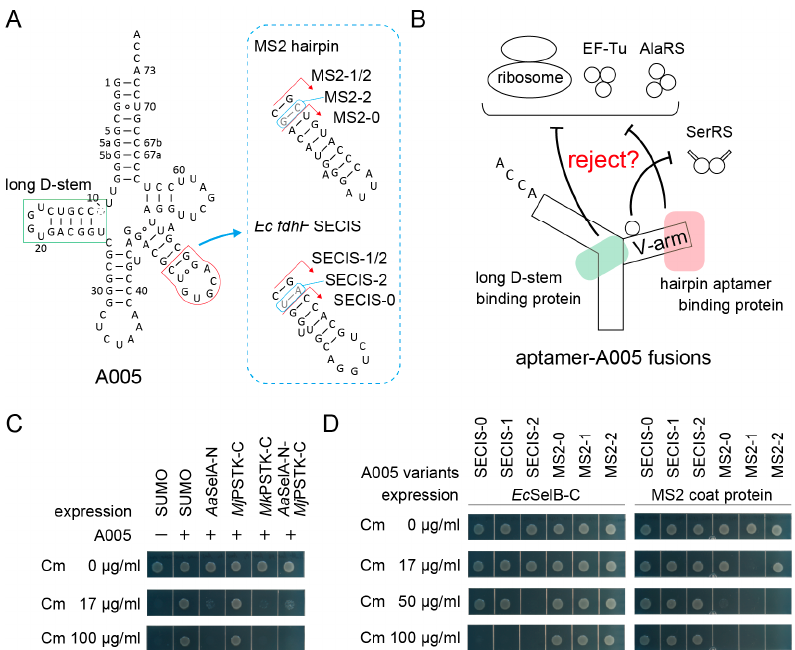
Figure 3. Sequestration of aptamer-tRNA fusions from the E. coli translation system via the expression of the cognate aptamer-binding proteins. ( A ) The cloverleaf structure of A005 tRNA variants having a hairpin RNA aptamer in the V-arm. The long D-stem of (9/3) allo-tRNAs and tRNA Sec species is a binding site for tRNA Sec -binding enzymes SelA and PSTK. ( B ) Strategy for the sequestration of the aptamer-A005 fusion variants. ( C ) The A005 tRNA molecules were almost fully sequestered by the N -terminal domain of Aquifex aeolicus ( Aa ) SelA and the C -terminal domain of Methanopyrus kandleri ( Mk ) PSTK but not by the C -terminal domain of Methanocaldococcus jannaschii ( Mj ) PSTK. ( D ) The SECIS-A005 fusions were sequestered by the C -terminal domain of E. coli SelB, while the MS2-A005 fusions were sequestered by the MS2 coat protein. Among the fusion tRNAs, the A005-MS2-1 variant was most e ff ectively sequestered. The SUMO protein was used as a negative control and as a N -terminal solubilizing tag for the SelA, PSTK, and SelB